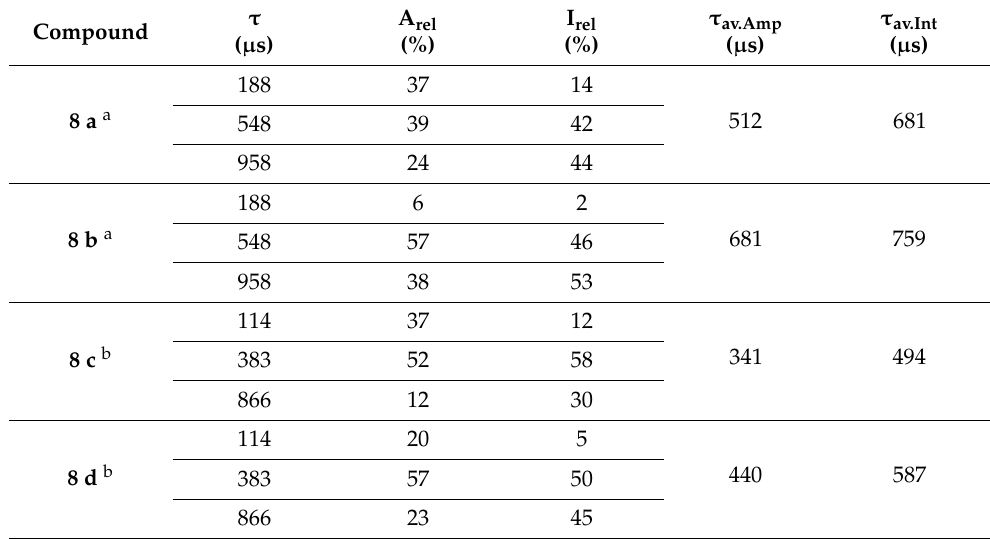
Figure 13. The luminescence decay curves of 8 a – d detected at 615 nm; excitation at 375 nm. Table 4. The parameters obtained from the fitting of luminescence decay kinetics obtained at 615 nm with an excitation of 375